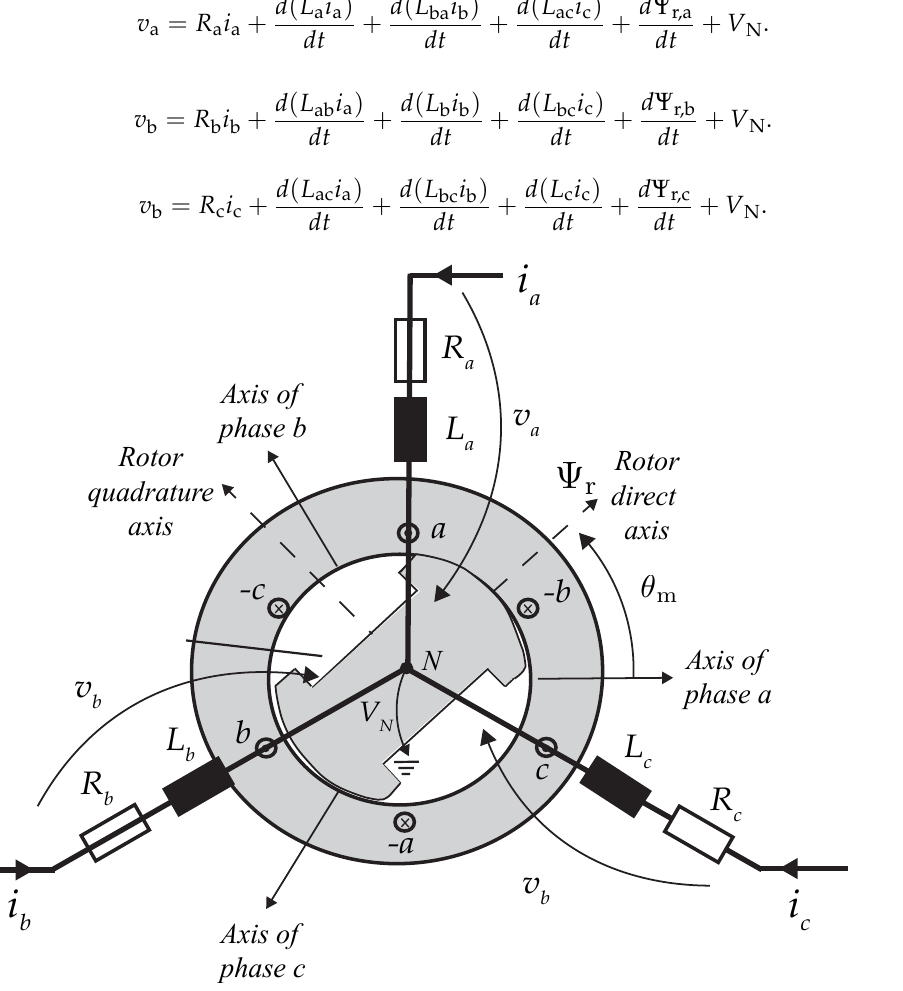
Figure 3. Synchronous motor circuit scheme and star point